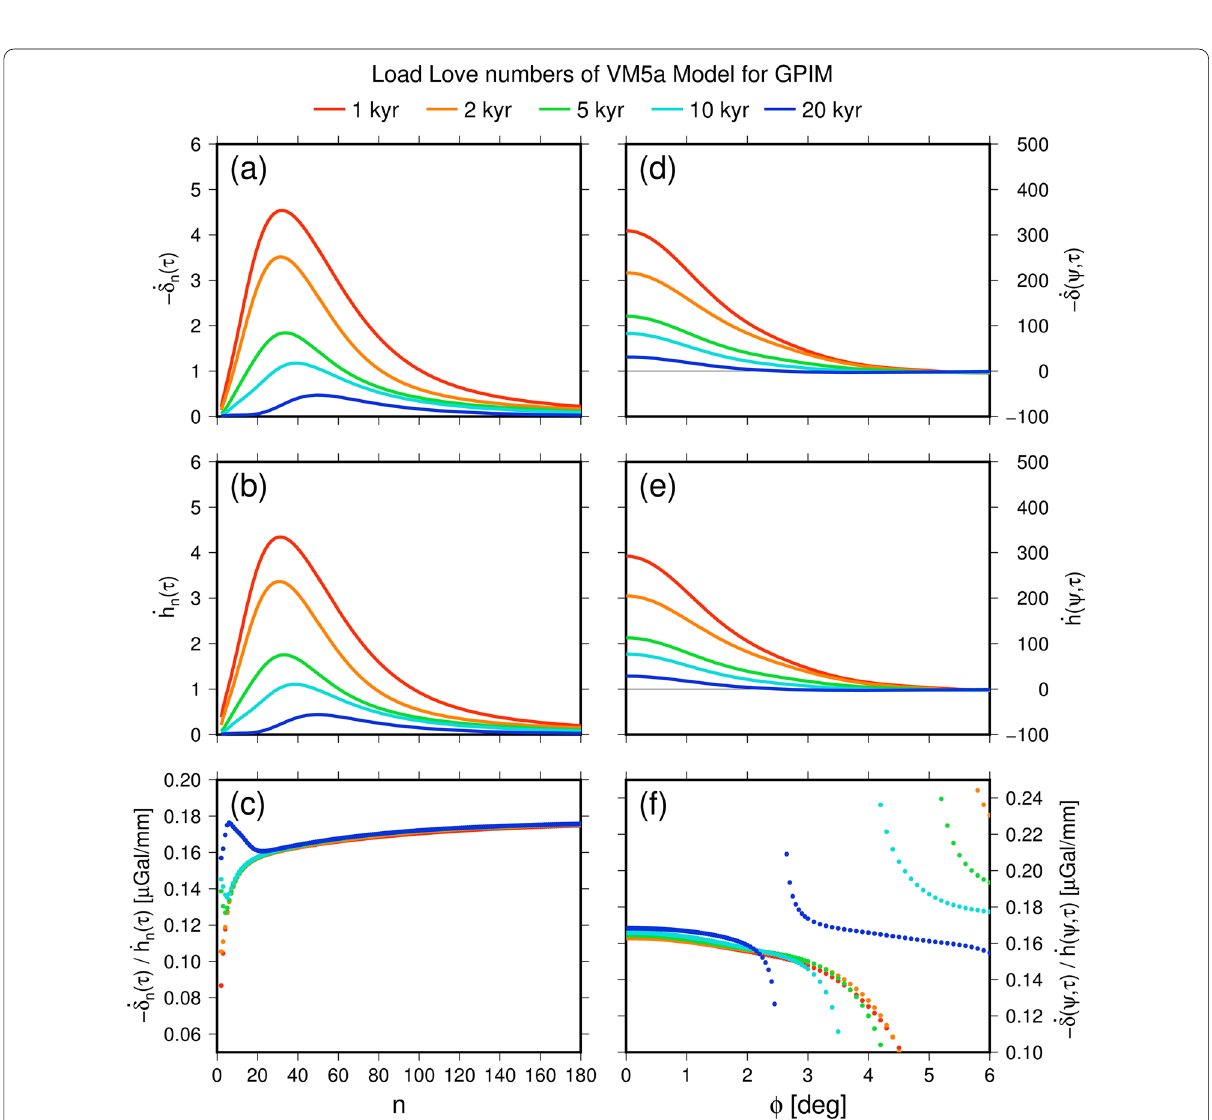
Fig. 6 Behavior of the load Love numbers obtained from the VM5a model for GPIM (Peltier et al. 2015). a The variation in −˙ δ n (τ) with degree ( n ) ˙ h and time ( τ ). b The variation in n (τ) with degree ( n ) and time ( τ ). c The variation in the ratio of variation in −˙ δ(ψ , τ) with angular distance ( ψ ) and time ( τ ). e The variation in ˙ h (ψ , τ) ratio of −˙ δ(ψ , τ) to with angular distance ( ψ ) and time ( τ